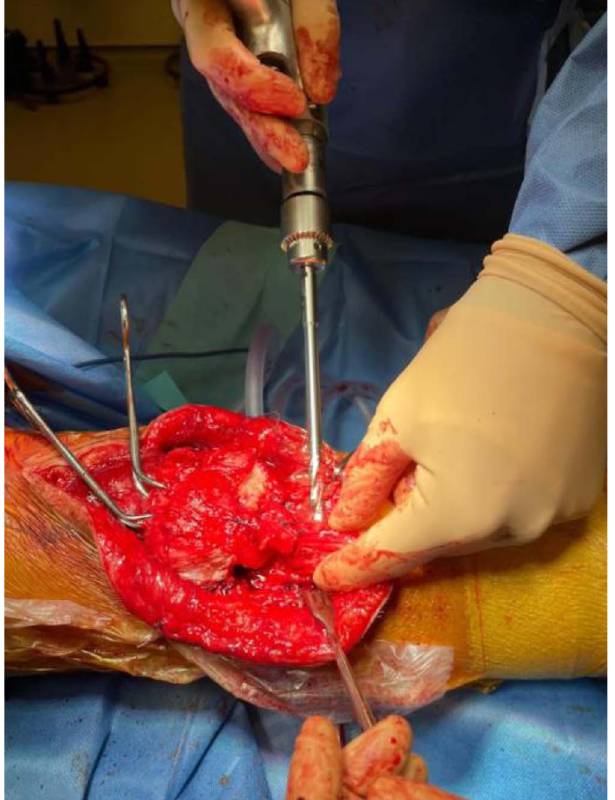
Figure 9. 7 mm cannulated drill is passed through the 2.7 mm guidewire.